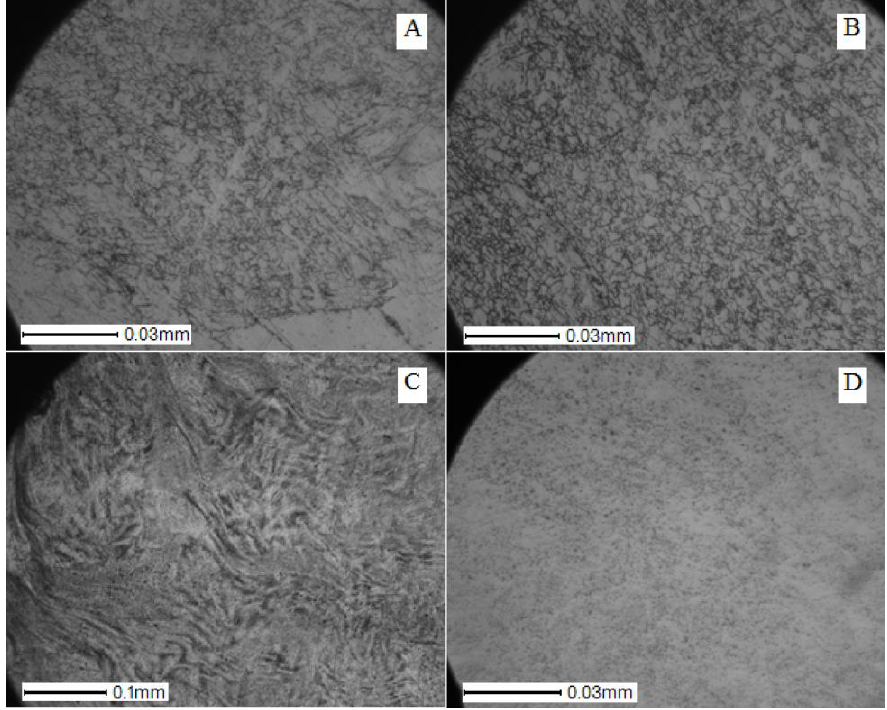
Figure 6. Photos of the microstructure of bars of the Ti–28Nb–5Zr alloy with ( A ) 8, ( B ) 4, ( C ) 2.5, and ( D ) 1.5 mm diameters in the transversal direction of the section.